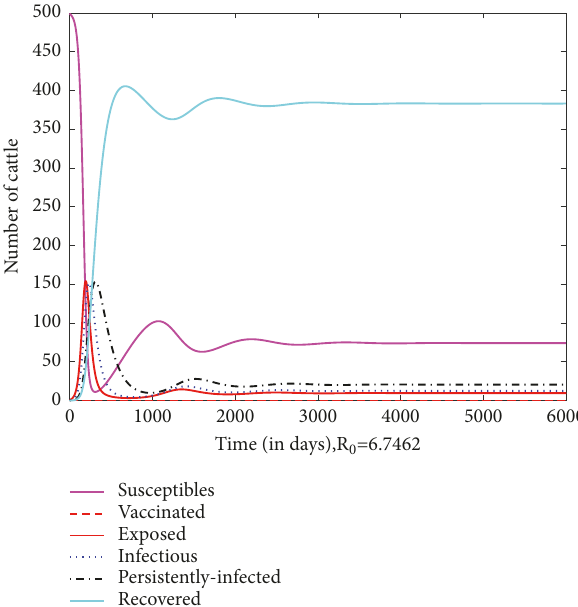
Figure 4: Number of cattle in each compartment with baseline parameter values in Table 1 with 𝜌 = 𝛼 𝑡 = 0 , 𝐼 0 = 1 , 𝑆 0 = 499 , and = 3.9399 . 𝑉 0